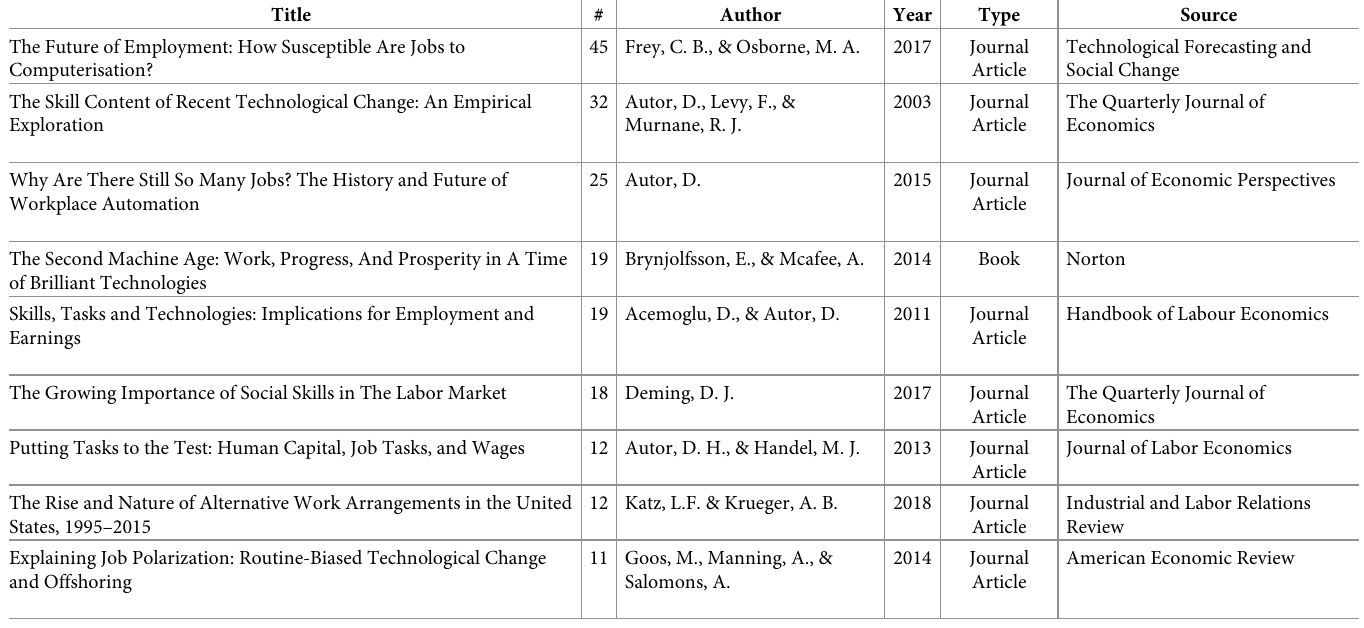
Table 5. Most frequently referenced scholarly sources.